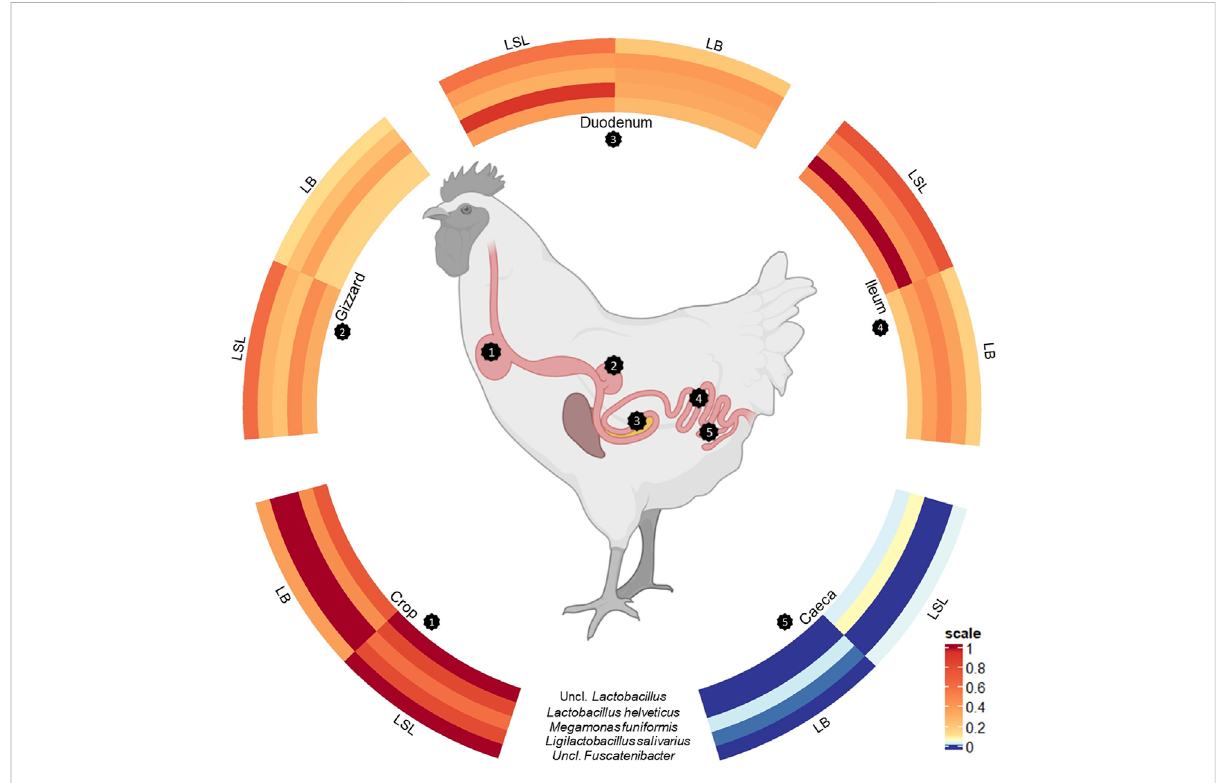
FIGURE 4 Scaled circulized heatmap of the fi ve core microbiota separated by the GIT sections (crop, gizzard, duodenum, ileum, and caeca) and breed (LSL,